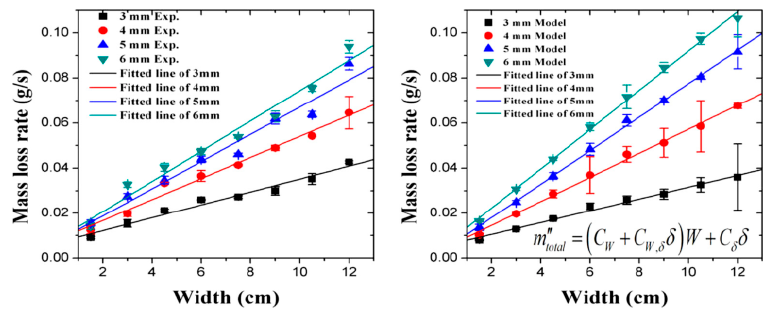
Figure 24. Relationship between MLR and sample geometry Figure 31. Relationship between MLR and sample geometry [17].